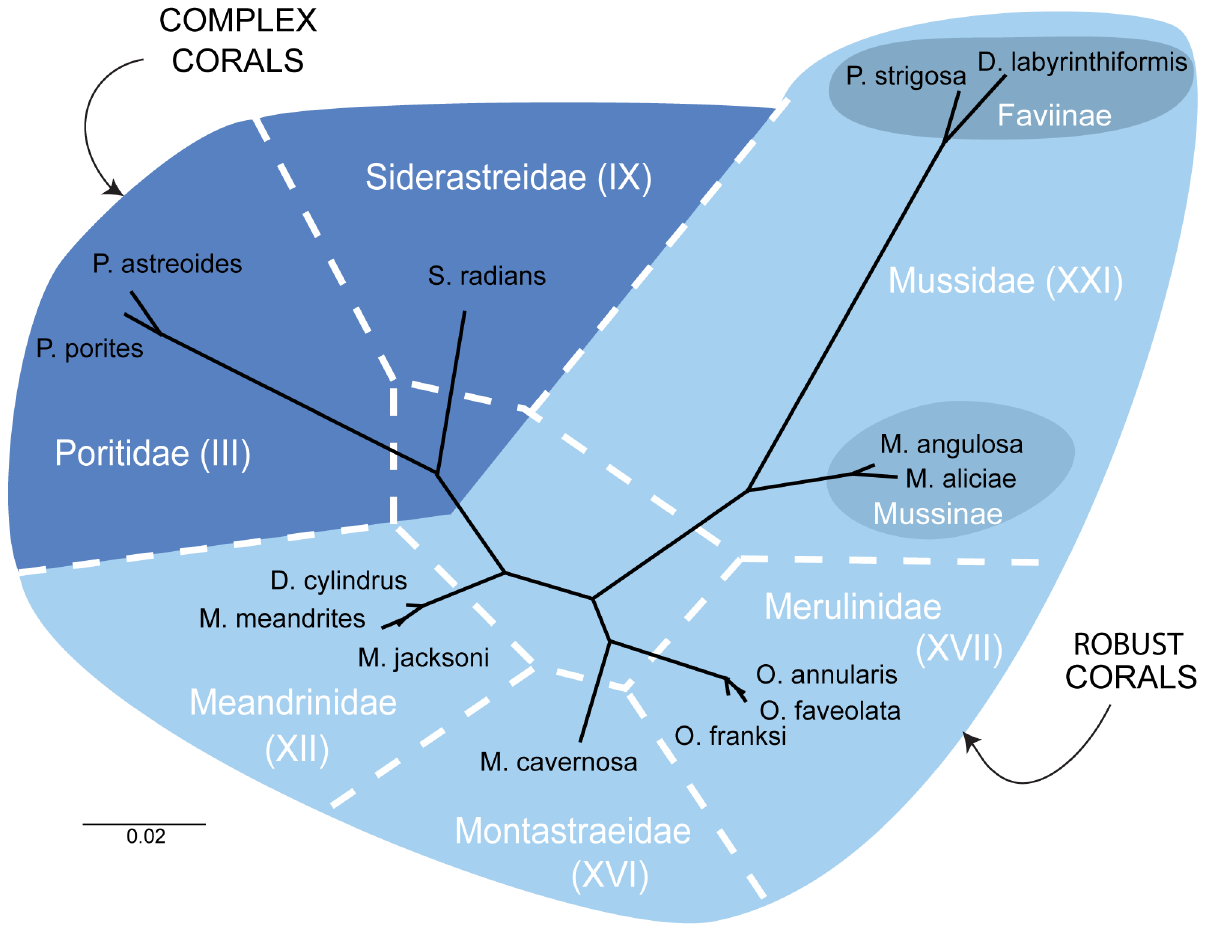
Figure 1. Un-rooted Bayesian phylogenetic reconstruction (dark line) using the 28S rDNA (657–685 bp) region from 14 species of Caribbean corals used in this study. The dotted lines represent the family groupings as recently proposed by Budd et al. [22]. All nodes in this tree have support (posterior probability) values higher than 0.80. doi:10.1371/journal.pone.0104787.g001 PLOS ONE |